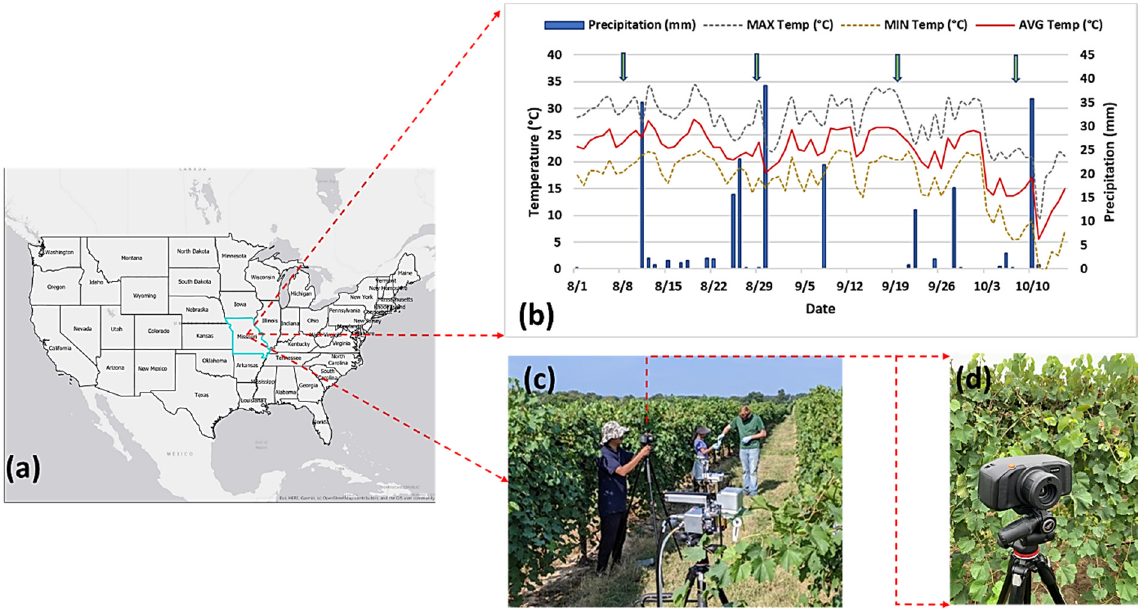
Figure 1. The experiment site at the University of Missouri South Farm Research Center, Columbia, MO (38.92 N, − 92.28 W) ( a ). The average temperature and precipitation during the experimentation period in summer 2019 ( b ). The arrows in ( b ) indicate the hyperspectral measuring dates. The SPECIM IQ sensor with a tripod ( c ). A close-up view of the SPECIM IQ sensor ( d ). The sensor produces hyperspectral images measuring 512 × 512 pixels with 204 spectral bands.